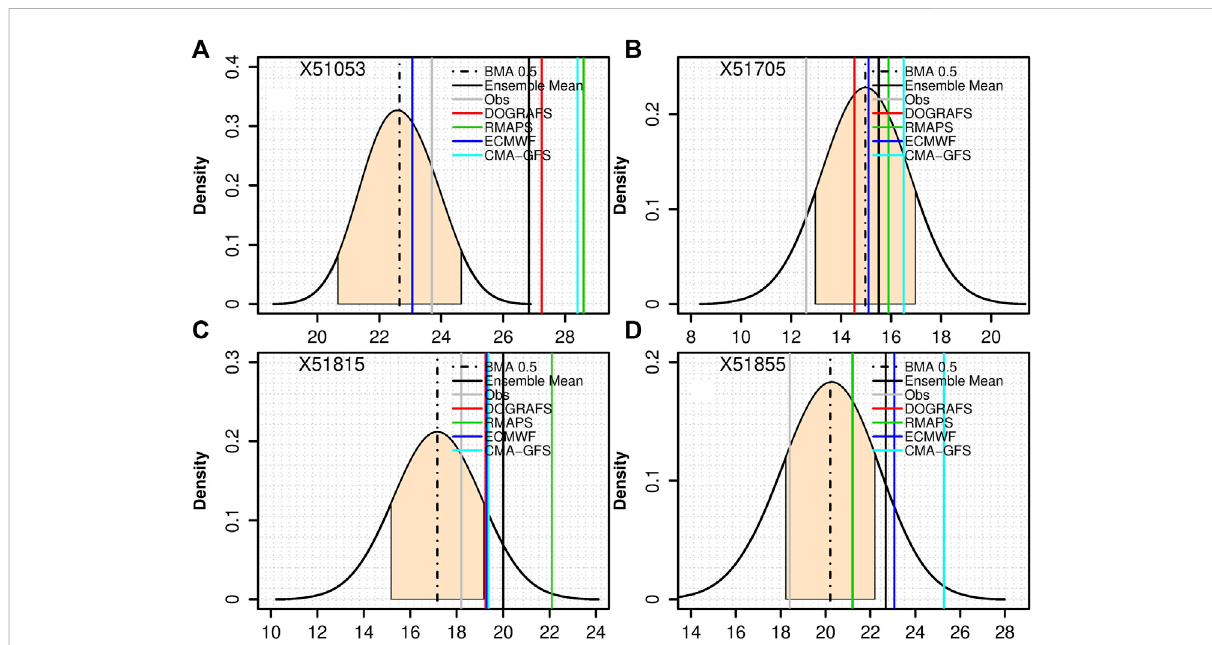
FIGURE 4 Deterministic forecasts and BMA probability forecasts of 2-m temperature at stations (A) X51053, (B) X51705, (C) X51815, and (D) X51855 with a lead time of 24 h. The black curve and black dotted line represent the BMA probability forecast curve and deterministic forecast curve, respectively. Gray and black solid lines represent the observed and multi-model ensemble mean deterministic forecasts; the remaining solid lines represent the deterministic forecasts of the four models. The shadow represents the probability centered on the BMA deterministic forecast with an interval length of 2 ° C.